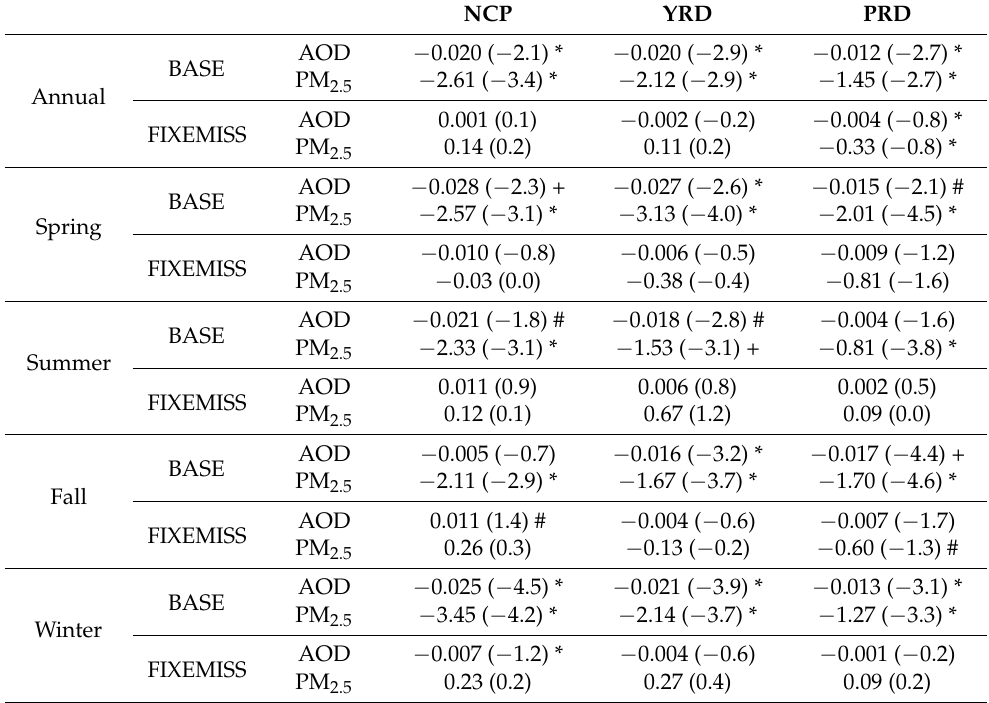
Table 1. GEOS-Chem-simulated inter-annual trends of annual and seasonal mean AOD (yr − 1 ,